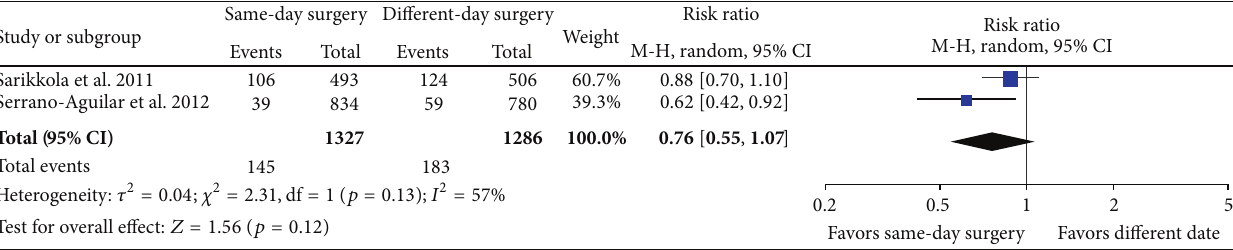
Figure 1: Forest plot of any intra- or postoperative complication (including sensation of dry eyes). M-H: Mantel-Haenszel. CI: confidence